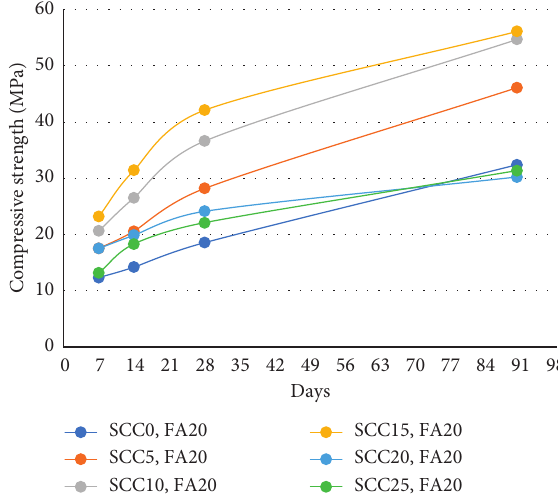
Figure 6: Compressive strength test results for concrete mixes with 20% replacement of fly ash.